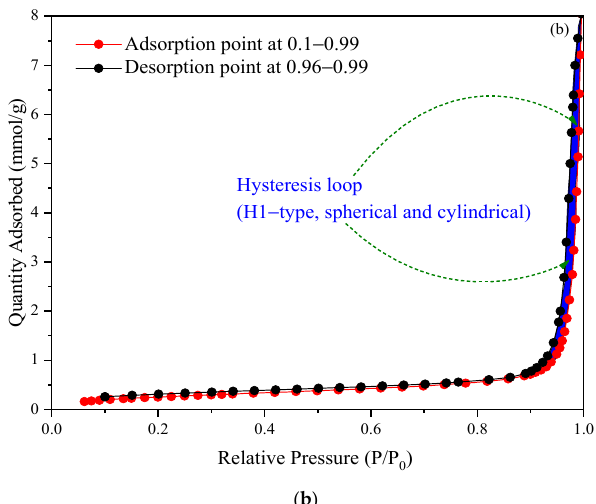
Figure 7. N 2 adsorption–desorption isotherms of H + Dowex-M4195 chelating resin: ( a ) before ion exchange and ( b ) after ion exchange. Table 2. Physical properties of H + Dowex-M4195 and Cu(II)-loaded H + Dowex-M4195 obtained from a different